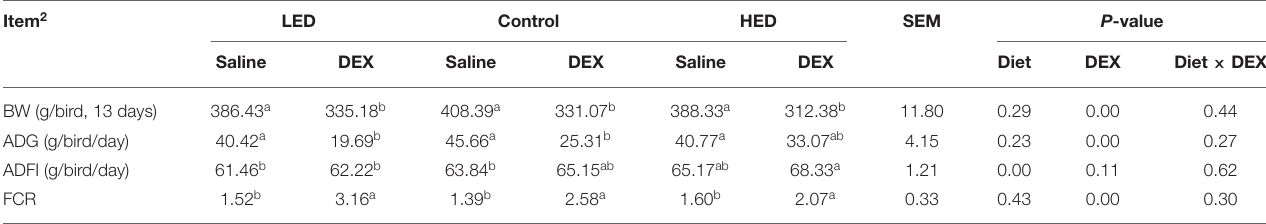
TABLE 4 | Effects of DEX on the performance of 13-day-old broilers fed with different energy level diets 1